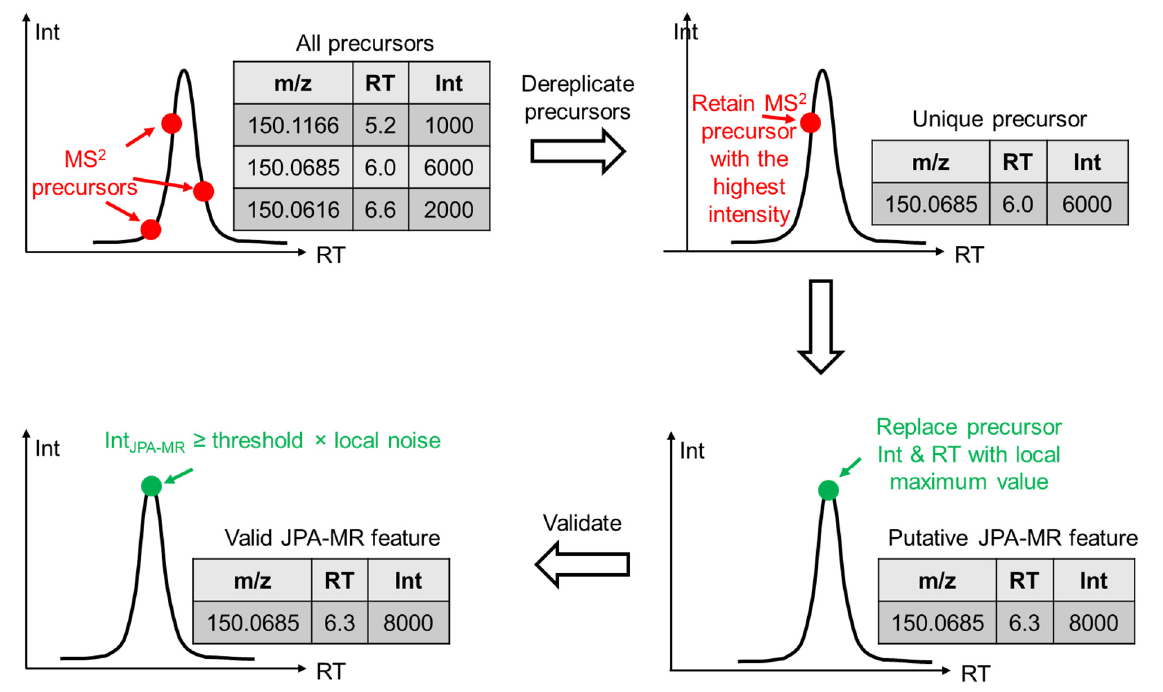
Figure 2. Mechanistic explanation of JPA-MS 2 recognition (JPA-MR) in extracting metabolic fea- tures.